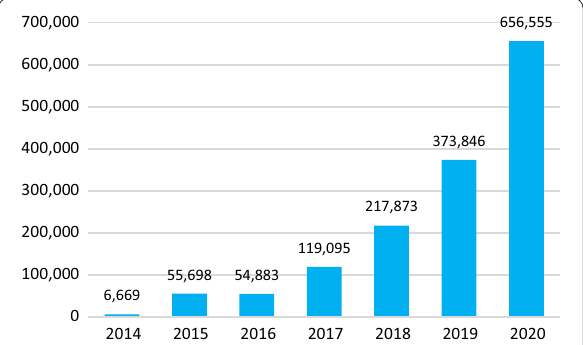
Fig. 2 Number of accesses* by calendar year (Source: Springer). *Accesses are defined as the number of times full text or PDF versions of articles are accessed directly from the journal website and SpringerLink. Downloads are defined as HTML, LookInside, PDF, and Epub clicks. Please note that accesses do not include article downloads from mirror databases, such as PubMed Central